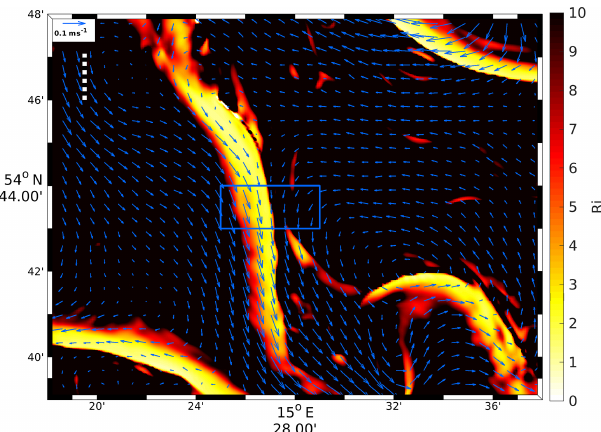
Figure 17. R100, 26 June: Richardson number Ri at 2m of depth and total top-layer velocity V drawn at 600m resolution. For the position of the area, see the red box in Fig. 7d. The magenta box indicates the position of the maps shown in Fig. 16a–e. It is identical to the black box in Fig. 15. The dashed ruler represents a distance of